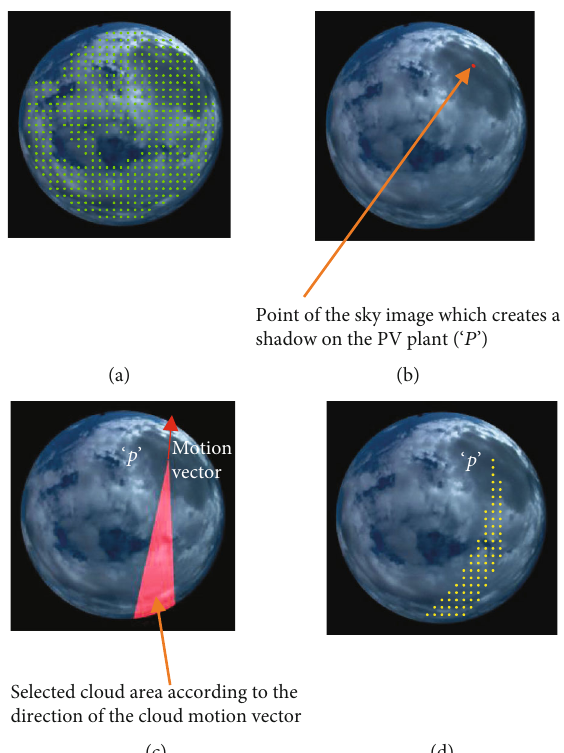
Figure 16: (a) Selected cloud pixels, (b) the image location ( P ) which creates a shadow on PV plant at location 1, (c) selected cloud area according to the direction of the cloud motion vector, and (d) the selected distortion removed points